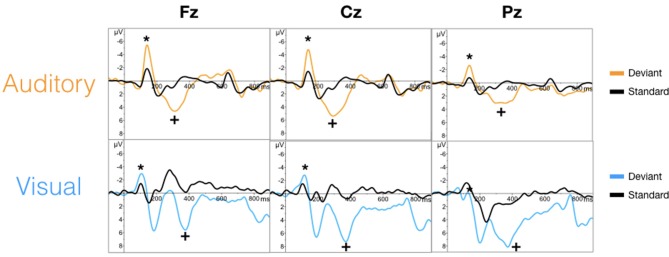
Grand averaged waveforms for the N100 (*) and P300 (+) component in auditory (top) and visual (bottom) modalities.